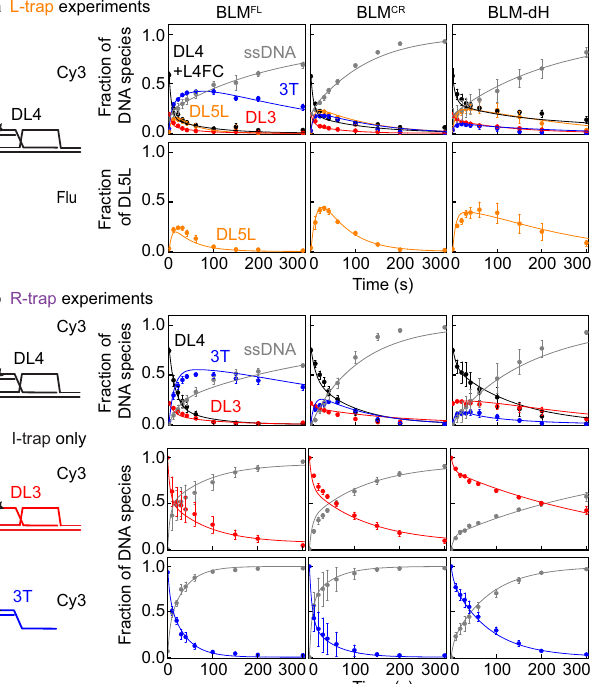
Fig. 6 Kinetics of D-loop processing by BLM constructs. a , b Kinetic pro fi les of DL4 unwinding by BLM FL , BLM CR , and BLM-dH in the presence of ( a ) L-trap or ( b ) R-trap. The fraction of DL5L compared with initial DL4 was determined from the fl uorescein signal (cf. Supplementary Fig. 4) by dividing the measured pixel density by the density of 30 nM L-trap multiplied with the initial fraction of DL4 determined from Cy3 scanning of the same gel. In R-trap experiments (Supplementary Fig. 5), we did not observe the formation of DL5R for any BLM construct. c Kinetic pro fi les of DL3 and 3T unwinding obtained in I-trap-only experiments. Data shown are identical to those in Fig. 4a (used for both types of analysis). Color coding of DNA species is as in Figs. 3, 5, and Supplementary Fig. 7: DL5L ( fi ve- stranded structure): orange, DL4 (4-stranded D-loop-like structure): black, DL3 (3 stranded D-loop like structure): red, 3T (3 ′ -tailed dsDNA): blue, and ssDNA: gray. Means ± SEM ( n = 3) are shown on all panels for the detected fractions of DNA species at each time point determined from independent experiments with individual protein constructs. Solid lines show global best- fi ts of the model described in Supplementary Fig. 7 to all unwinding data (DL4, DL3, and 3T) of each enzyme variant. Source data are provided as a Source Data fi le.